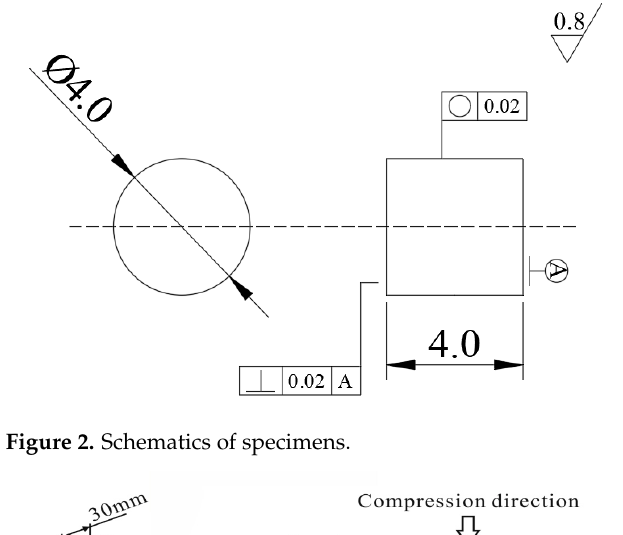
Figure 2. Schematics of specimens.